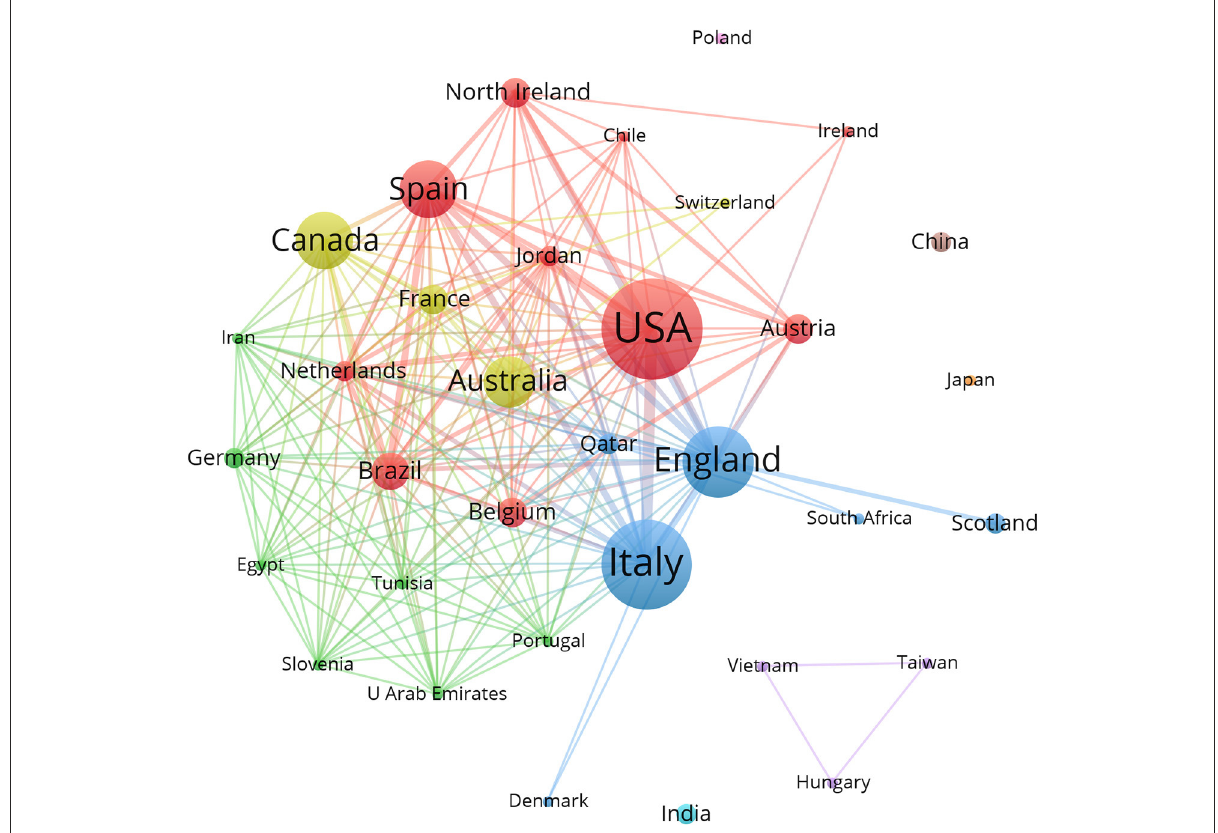
FIGURE3 Countries/regions Cooperation Network